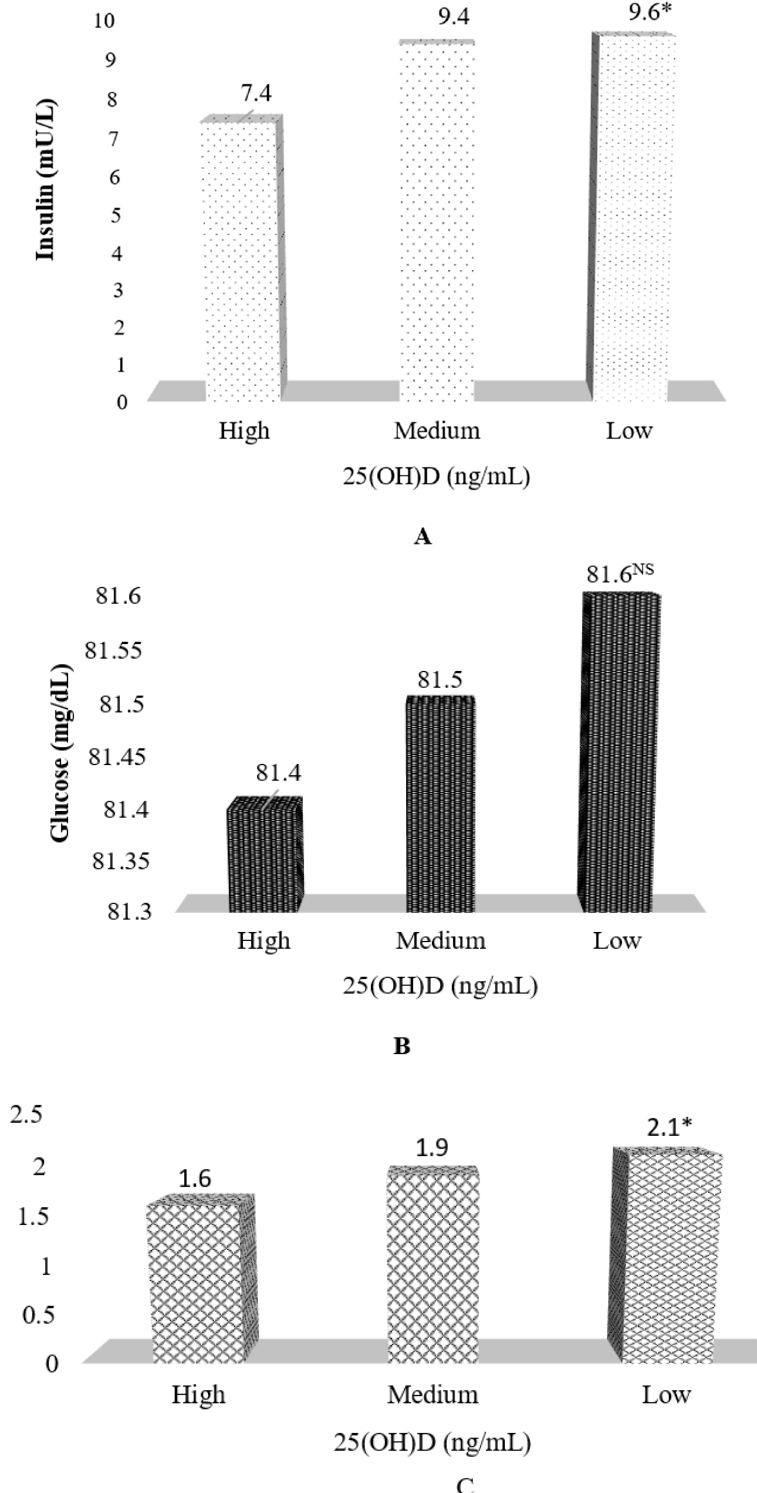
Figure 1. ( A – C ) HOMA index and related markers 1 by tertile of vitamin D levels. ( A ) Insulin levels by tertile of serum vitamin D; ( B ) Glucose levels by tertile of serum vitamin D; ( C ) HOMA index δ by tertile of serum vitamin D. 1 Values are adjusted by age, sex, BMI, Tanner stage. δ Homeostasis Model Assessment (HOMA index) was calculated as fasting insulin (U / L) × fasting glucose (mg / dL) / 405. * p < 0.001; NS: not statistically significant.